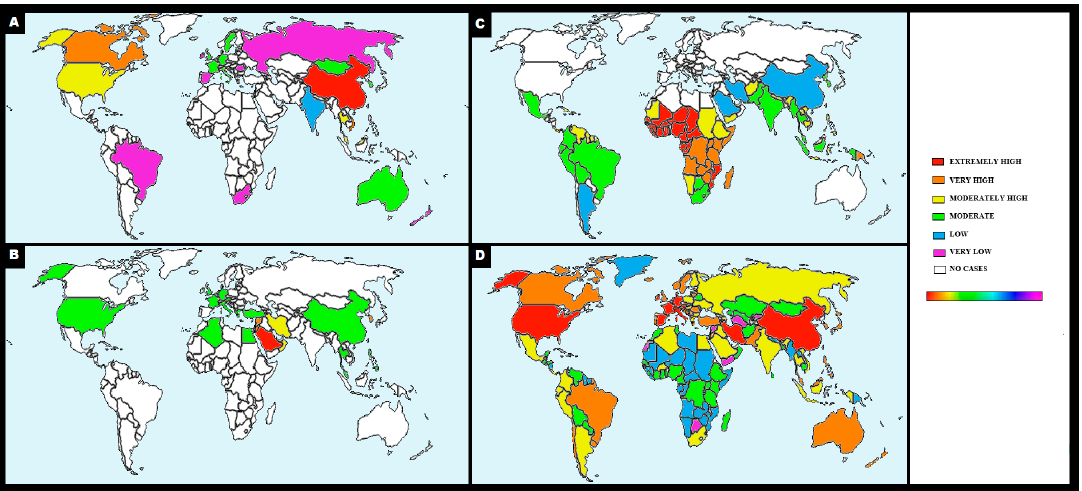
Figure 1. Distribution maps of betacoronaviruses and malaria. Color scale of the number of cases (white = none, light purple = very low, blue = low, green = moderate, yellow = moderately high, orange = very high, red = extremely high). Color bar indicates the sequence of positive values [very low number of cases = light purple to extremely high number of cases = red]. Panel A shows the map representing the spread of severe acute respiratory syndrome coronavirus 2 ( SARS-CoV) in the terminal phase of epidemic in 2003 (WHO data source) [7]. The map in the panel B represents the confirmed global cases of Middle East respiratory syndrome-related coronavirus (MERS-CoV) 2012-2017 as of 1 September 2017 (WHO data source) [8]. Panel C represents the map of countries with indigenous cases of malaria in 2000 and their status by 2017 (WHO data source) [9].In panel D is shown the distribution of coronavirus disease 2019 ( COVID-19) cases as of 25 March 2020 (WHO data source) [6].